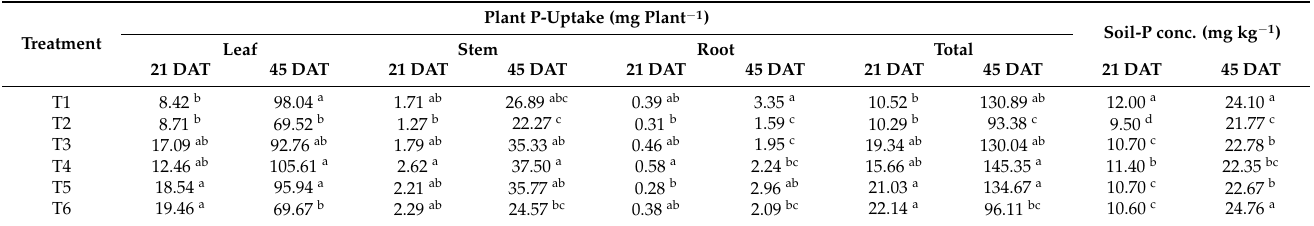
Table 3. Effects of chemical (mono-super phosphate), organic (rock phosphate), and PGPB (biofertil- izer) treatments on soil- and plant-phosphorus